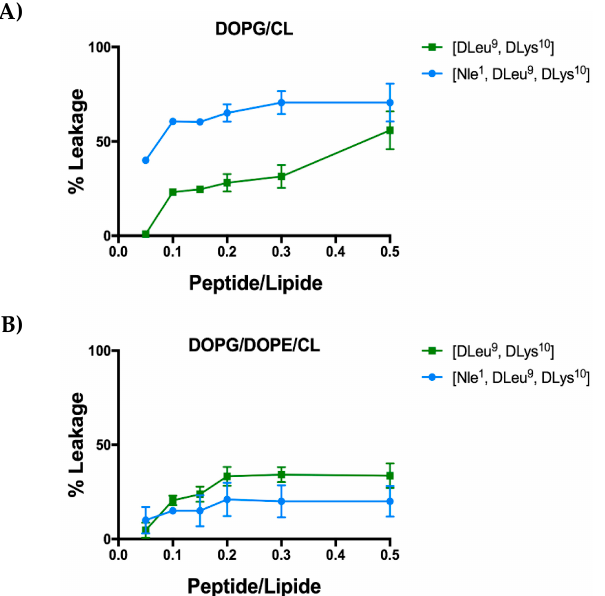
Figure 4. Leakage of DOPG/CL (panel A ) and DOPG/DOPE/CL (panel B ) after the treatment with the peptide [Nle 1 , D Leu 9 , vLys 10 ]TL. The leakage data of [ D Leu 9 , D Lys 10 ]TL were already reported in Bellavita et al. [27].